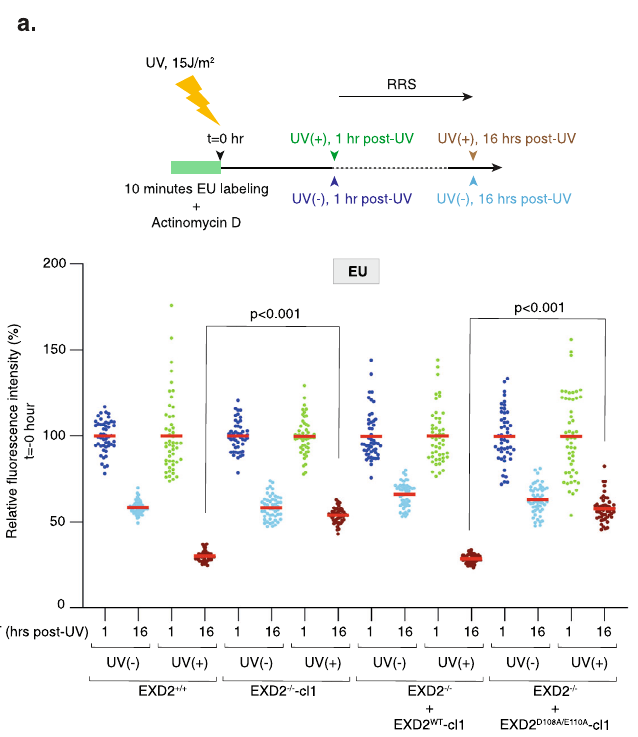
Fig. 4 | EXD2 degrades mRNA under synthesis at the time of UV irradiation. a Upper panel; Scheme of the EU pulse-chase method used to analyze the fate of mRNAbeingsynthesizedatthemomentofUVirradiation.Cellswereincubatedfor 30min with Actinomycin D (0.05 μ g/ml) to speci fi cally inhibit RNAPI transcription and mRNAs were pulse-labeled with EU for 10min prior to UV irradiation (15J/m 2 ). Cellswere let to recover for 1h or 16h post-UV before fi xation. Actinomycin D was maintained during the experiment. Lower panel; Cells were treated as indicated in theupperpanelandEUsignalswerequanti fi edusingImageJandnormalizedtothe value obtained at 1h set to 100%. Values are reported on the graph ( n =at least 50 cells). Red bars indicate mean integrated density. RT; recovery time. One-way ANOVA with post-hoc Tukey adjustment comparisons were used to determine the